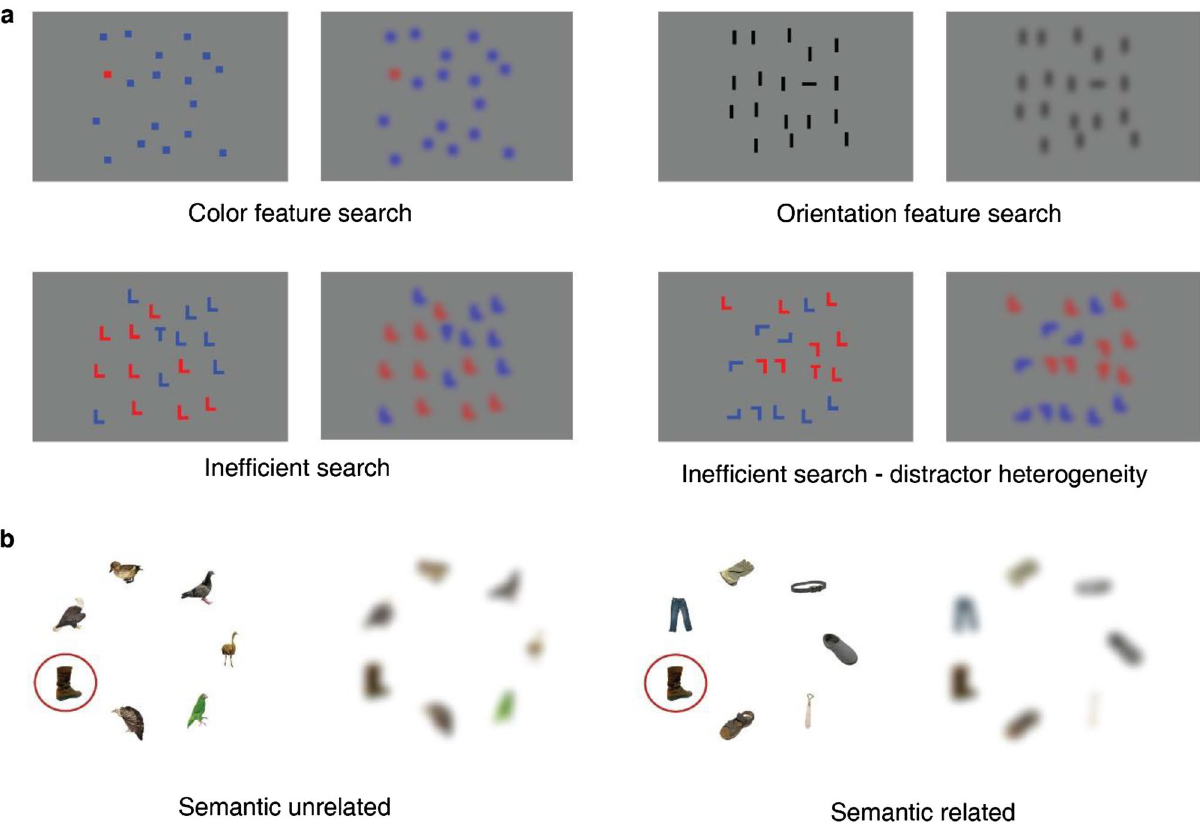
Figure 2. Examples of different search arrays before and after application of the blur filter. ( a ) Typical search arrays used in Experiment 1, including color feature search (1a, a red square as the target), orientation feature search (1b, a horizontal bar as the target), inefficient search with homogeneous (1c, a letter T as the target) and heterogeneous (1d, a letter T as the target) distractors. ( b ) Typical search arrays used in Experiment 2. The target was the boot, marked by a red rectangle here. Other objects were clothes in semantic related condition and birds in semantic unrelated condition.